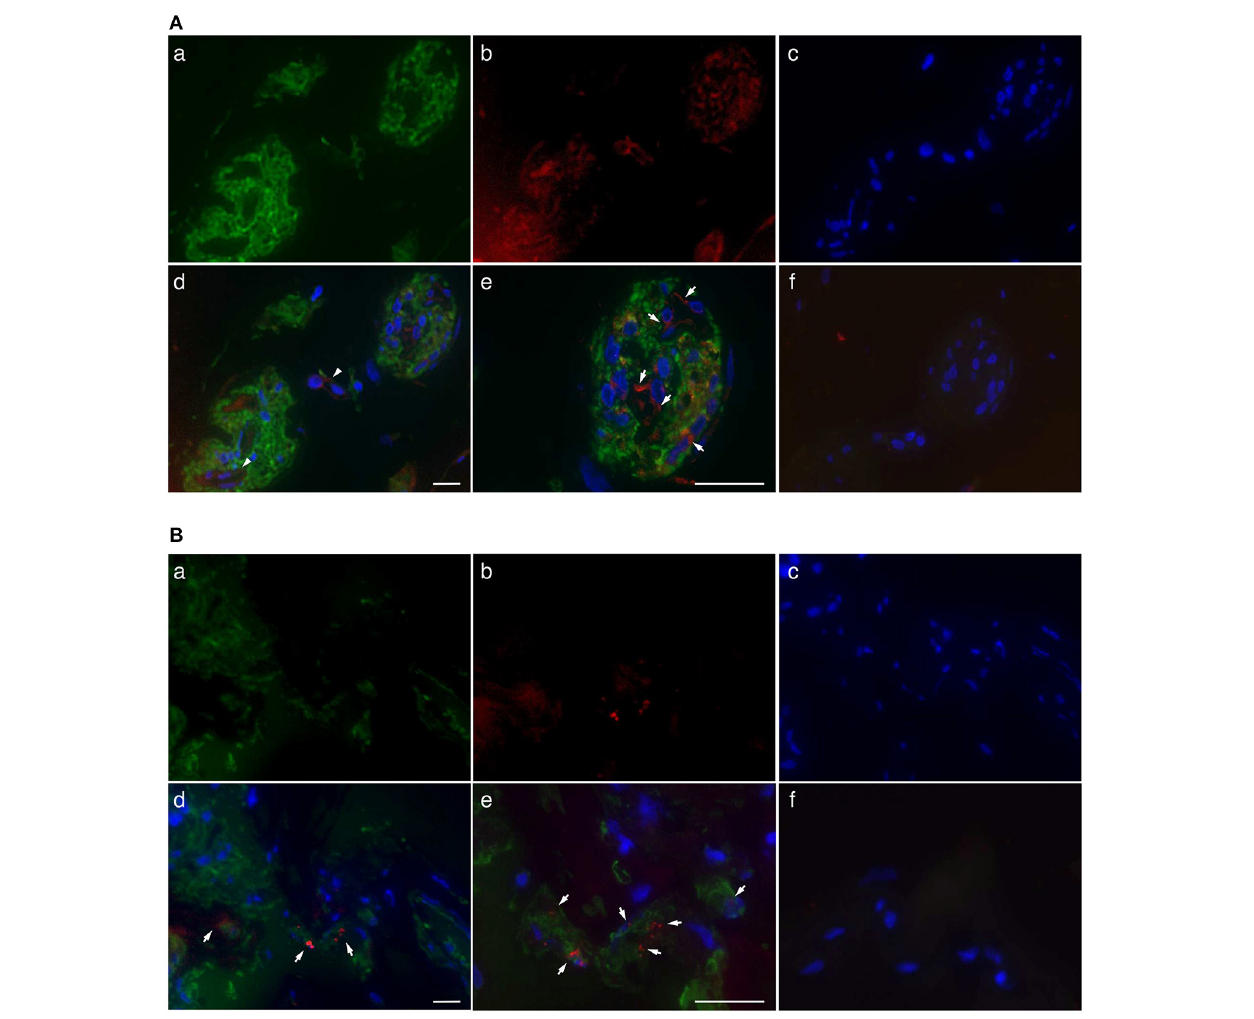
FIGURE 1 | Localization of ROCKs in GFAP-positive cells in fibrovascular tissues of patients with PDR. (A) Representative fluorescent micrographs of ROCK1 immunofluorescence in fibrovascular tissues. (a) Green, GFAP (Alexa Fluor ® 488). (b) Red, ROCK1 (Alexa Fluor ® 546). (c) Blue, nuclei counterstained with DAPI. (d) Merged image. Arrows indicate the co-localization of ROCK1 with GFAP in the fibrovascular tissue. (e) High-magnification image. (f) Negative control (mouse and rabbit IgG) in sequential sections. (B) Representative fluorescence micrographs of ROCK2 immunofluorescence in fibrovascular tissues. (a) Green, GFAP (Alexa Fluor ® 488). (b) Red, ROCK2 (Alexa Fluor ® 546). (c) Blue, nuclei counterstained with DAPI. (d) Merged image. Arrows indicate co-localization of ROCK-2 with GFAP in fibrovascular tissue. (e) High-magnification image. (f) Negative control (mouse and rabbit IgG) in sequential sections. Scale bars, 25 µ